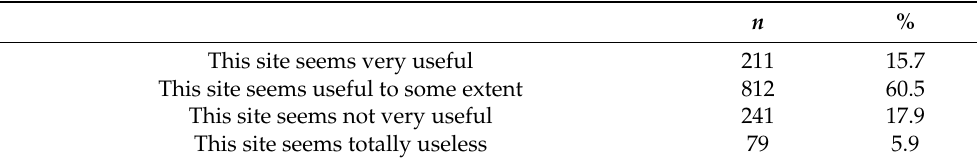
Table 12. The usefulness of “Information for Consumers Related to COVID-19” published by the NIBIOHN for